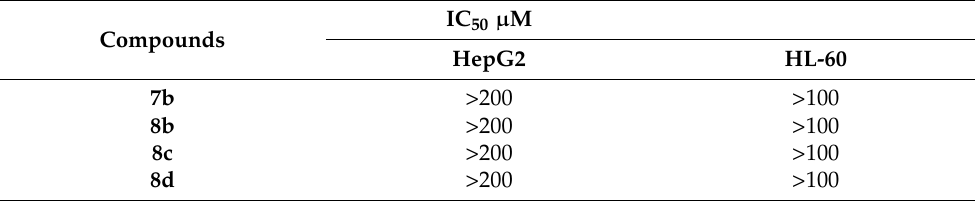
Table 2. Antiproliferative activity of selected compounds against different cell lines 1 .